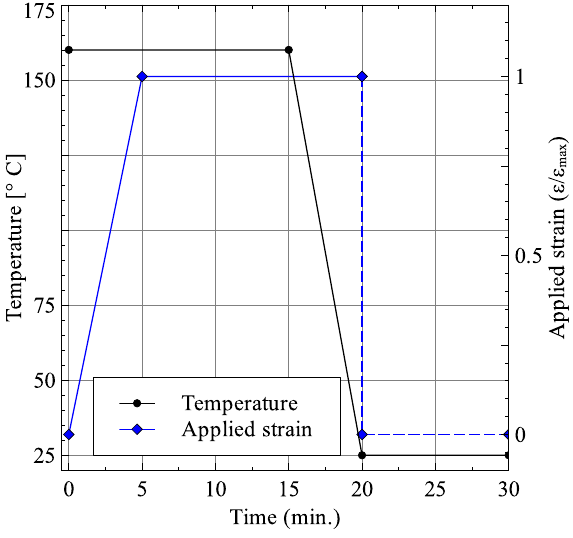
Figure 6. Applied temperature and strain load.